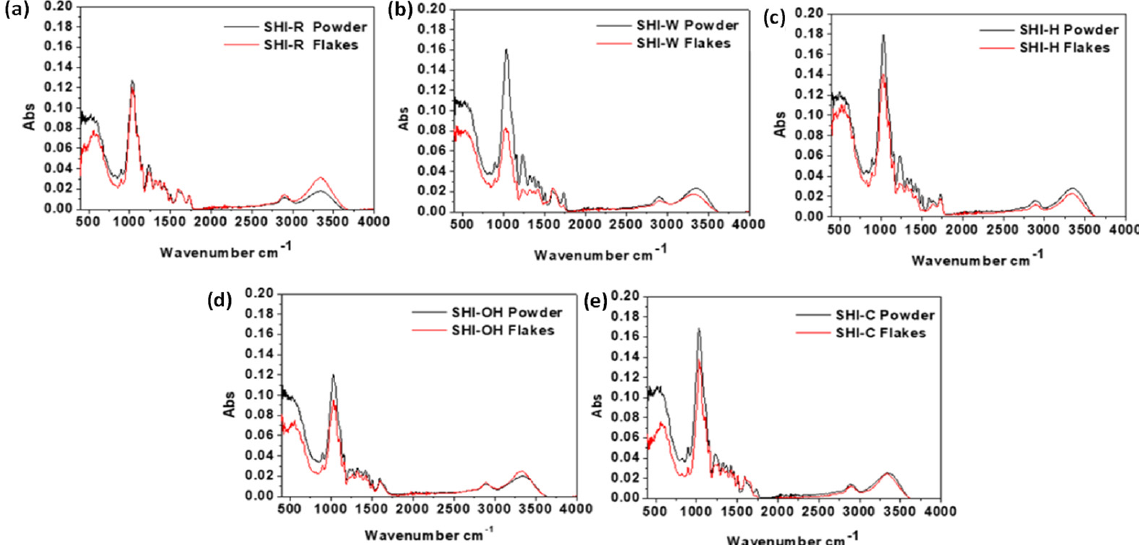
Figure 6. ATR-FTIR spectra of untreated SHI-R ( a ) and treated SHI-W, SHI-H, SHI-OH and SHI-C ( b – e ) hemp shives in powder and flake forms. Table 2. The main absorption bands in each ATR-FTIR spectrum of hemp shive samples in powder form and their assignment to chemical group vibrations and components.